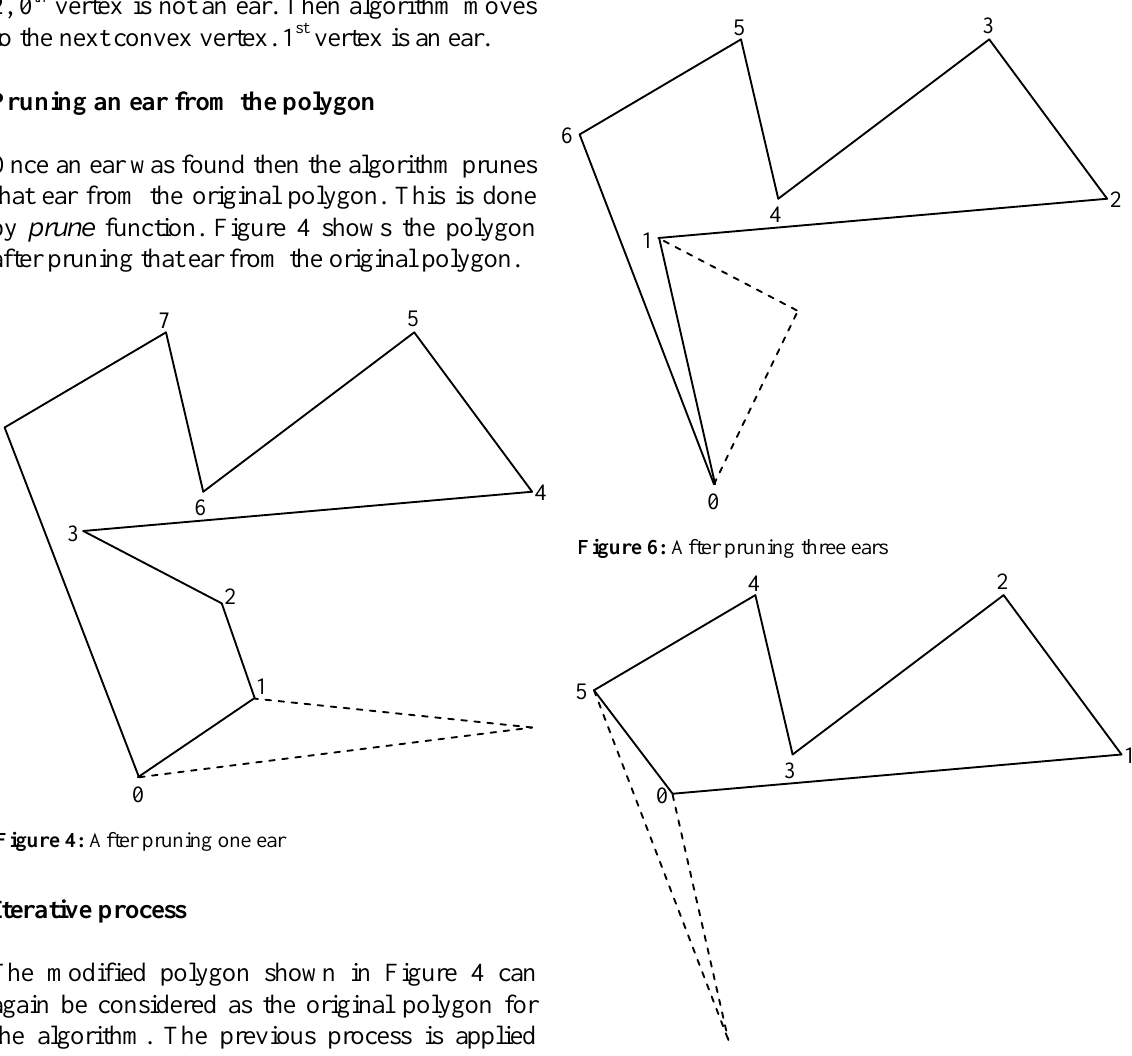
Figure 5: After pruning two ears